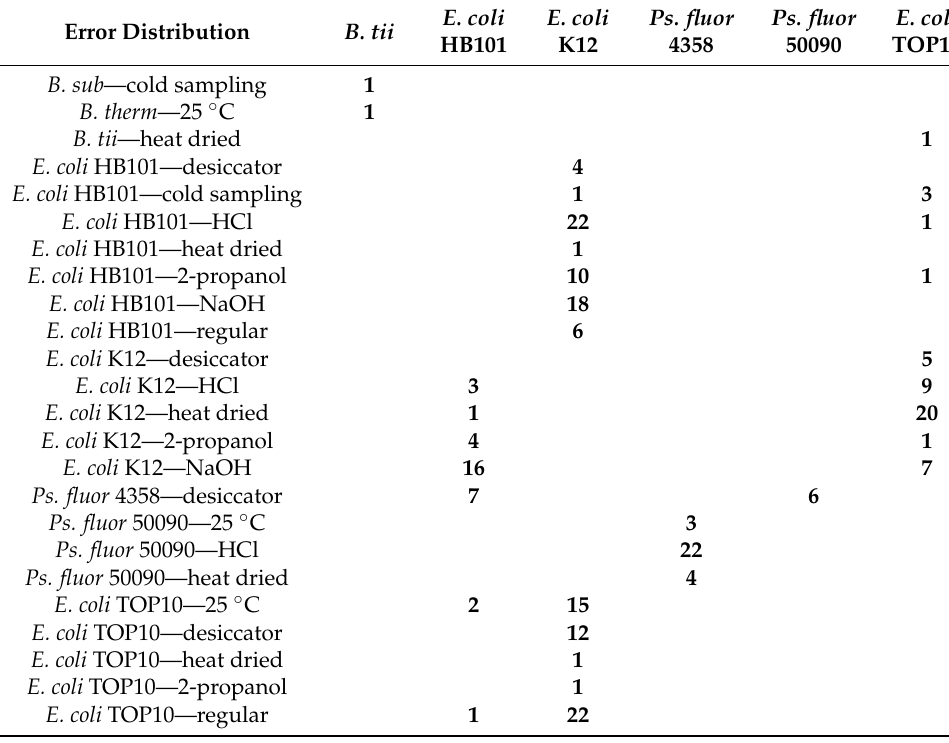
Table 2. Examination of the classification mistakes in the independent test data set at the sub-dataset level. The figures represent the overall number of misclassified spectra in the relevant